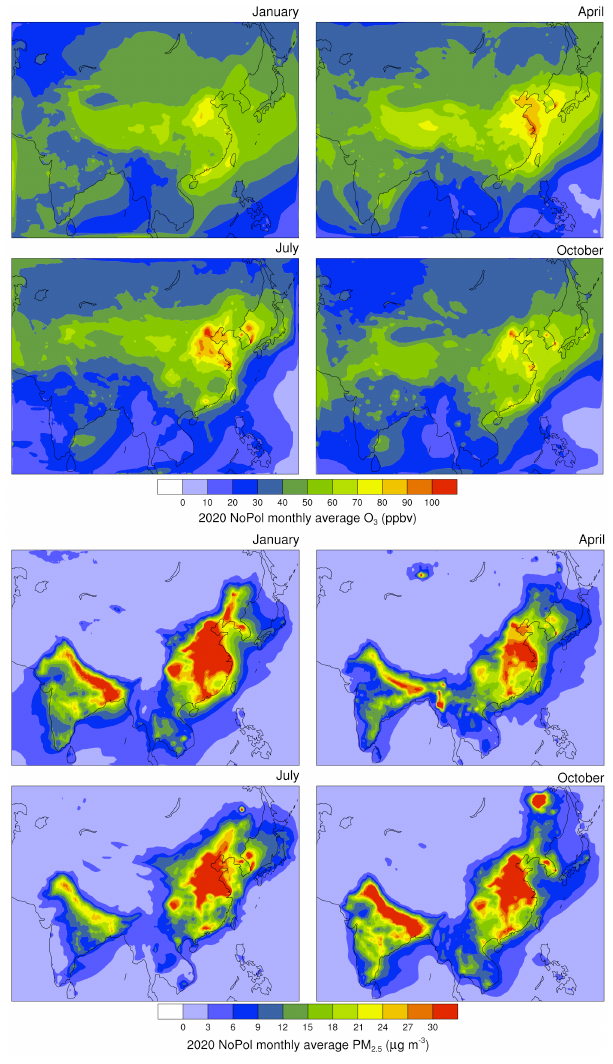
Fig. 8. The surface O 3 mixing ratios [ppbv] (top), and PM 2.5 concentrations [ µ g m -3 ] (bottom) in January, April, July and October modelled by WRF/Chem for 2020 NoPol scenario.